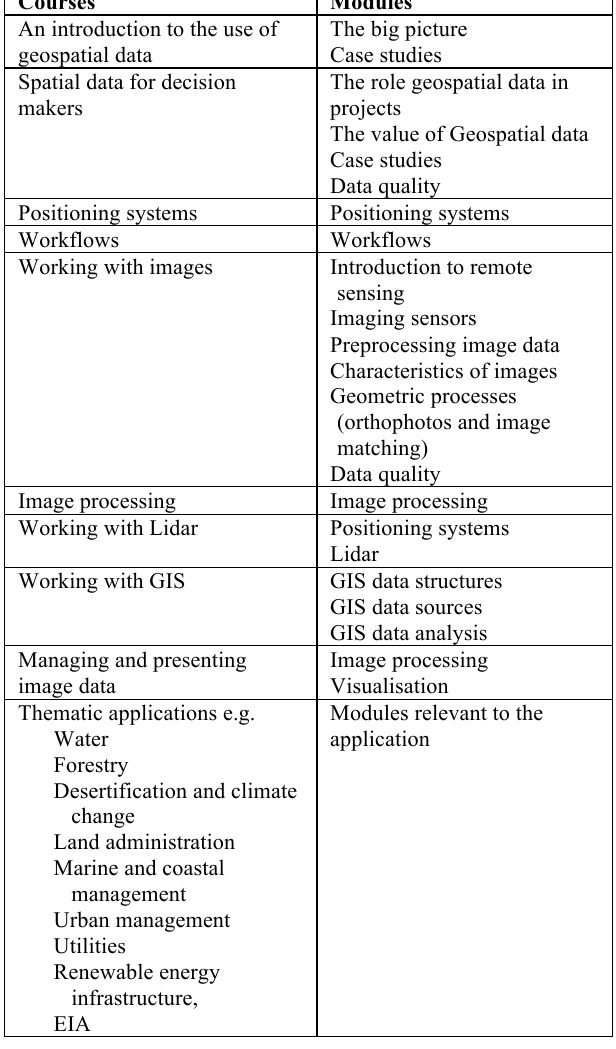
Table 1. Basic courses with proposed